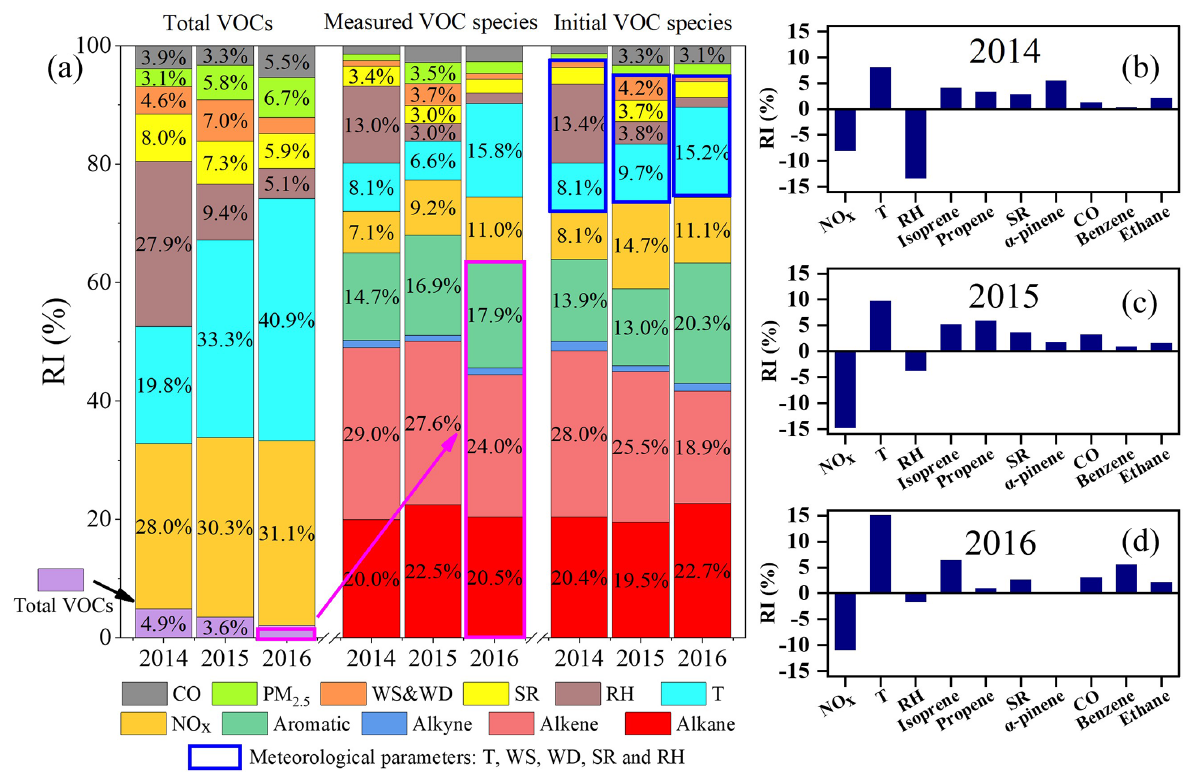
Figure 3. Percentage of RI for O 3 precursors and meteorological parameters (a) and the top 10 factors with high values of RI in 2014–2016 ( b–d : using initial concentrations of VOC